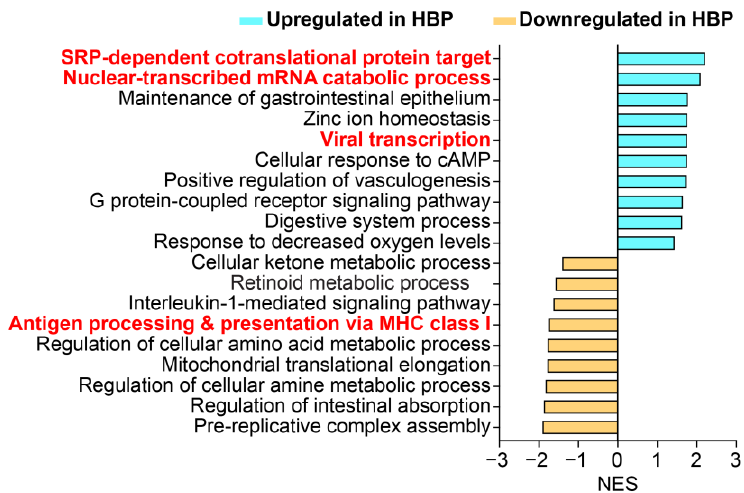
Figure 3. Pathways significantly enriched in colonic organoids from HBP subjects compared with REF subjects (FDR-corrected p < 0.05). NES: normalized enrichment score. Negative NES (Light blue bar) shows downregulated pathways and positive NES (Yellow bar) shows upregulated pathways in colonic organoids from HBP subject.